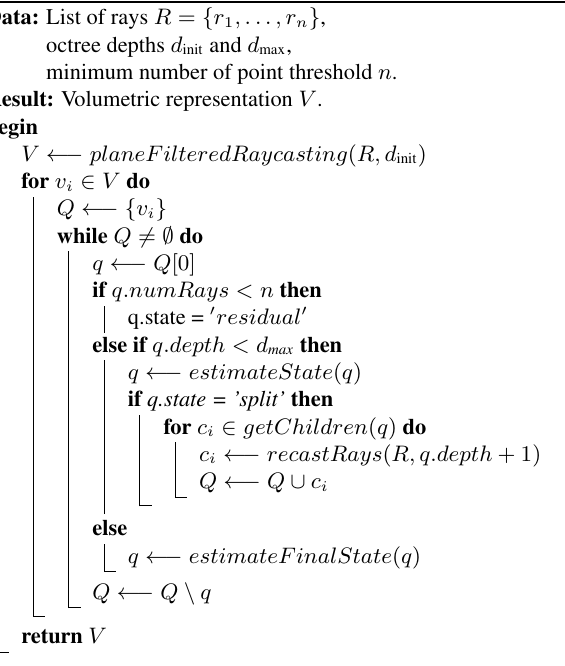
Algorithm 3: Overview of the volumetric point cloud approxi- mation algorithm.